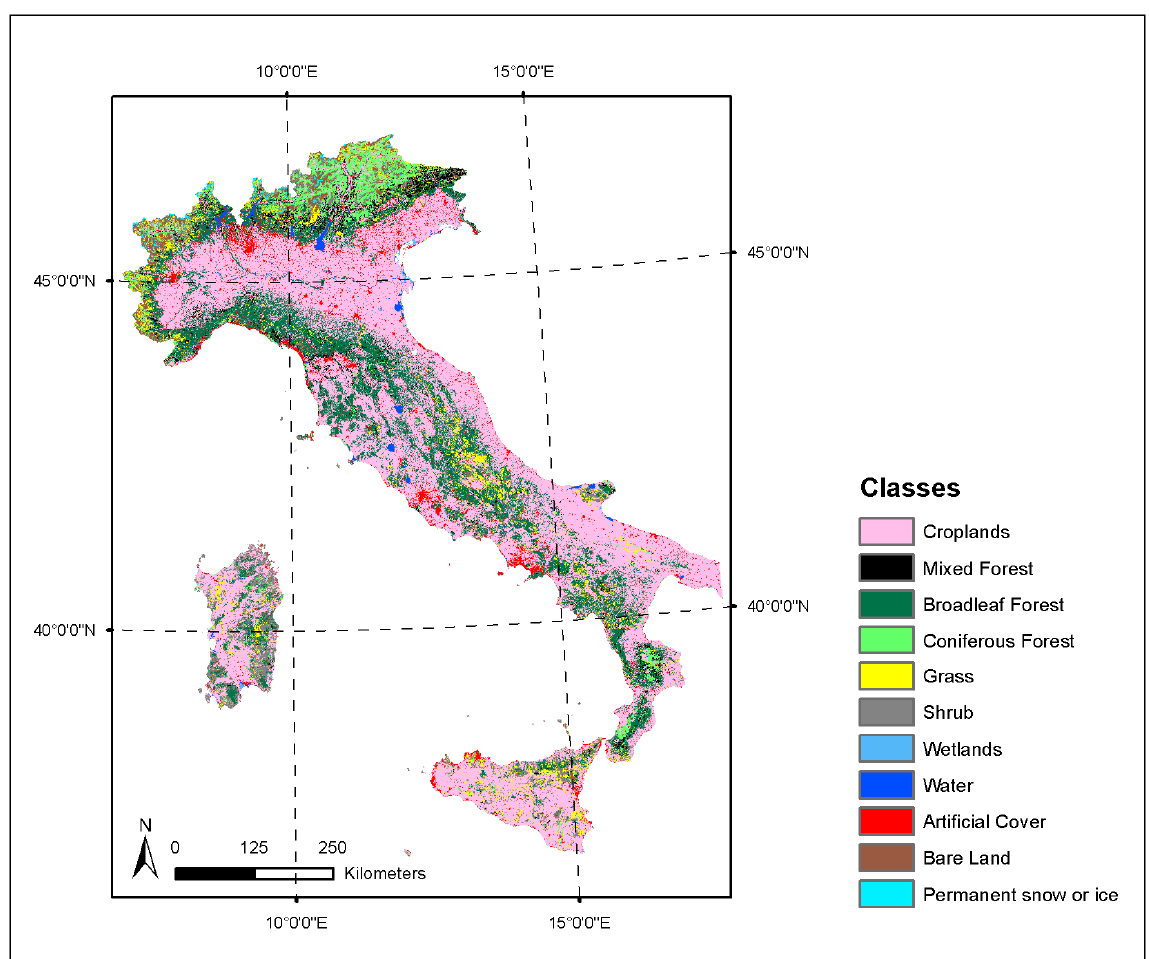
Figure 1. GlobeLand30 data for the Italian